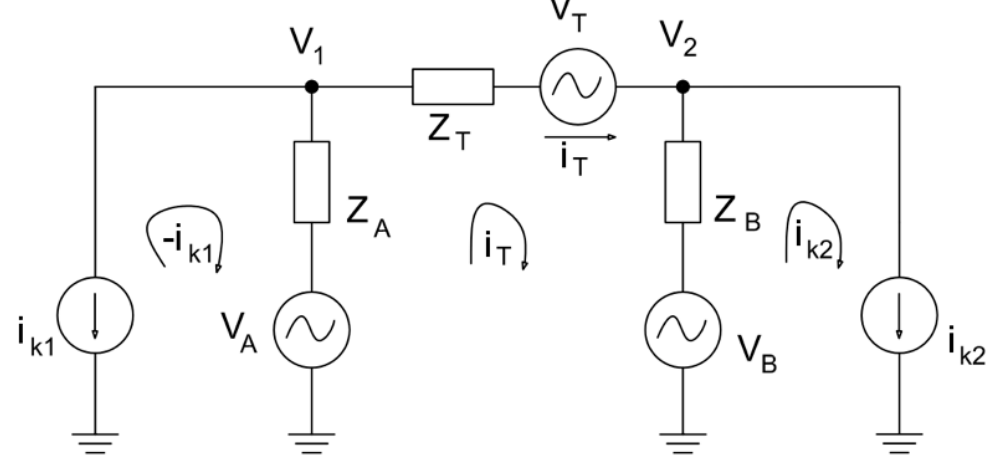
Figure 4. Model considering all system parameters.